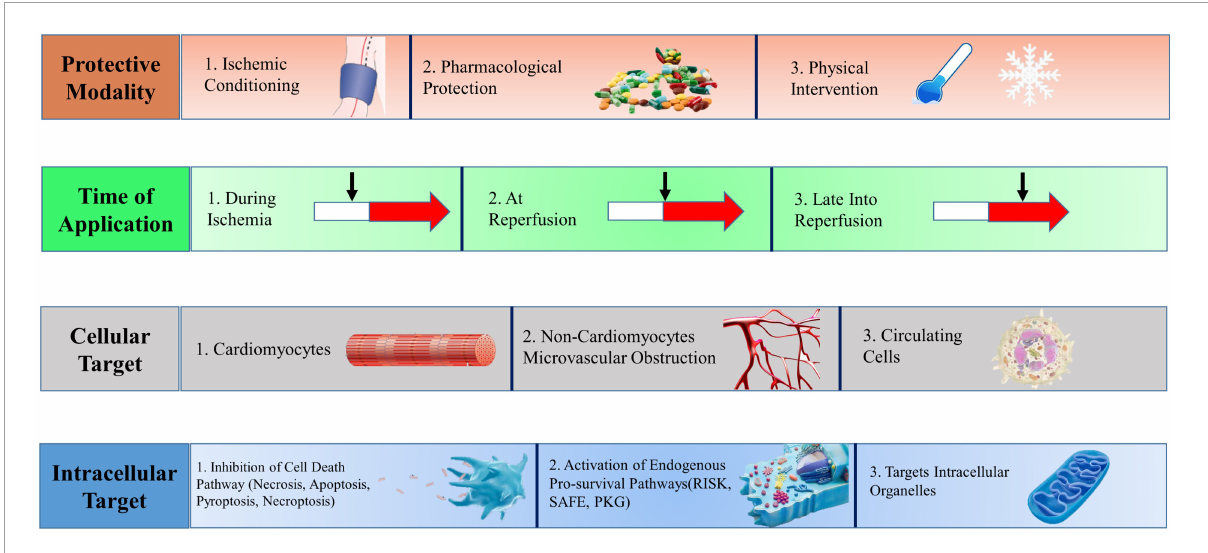
FIGURE1 Multitarget cardioprotective strategies to reduce myocardial infarction. Cardioprotective strategies fall into four broad categories, which may be combined in different manners to achieve multitarget cardioprotection. RISK, reperfusion injury salvage kinase; SAFE, survivor activating factor enhancement; PKG, protein kinase G. [Adapted from Davidson el al.